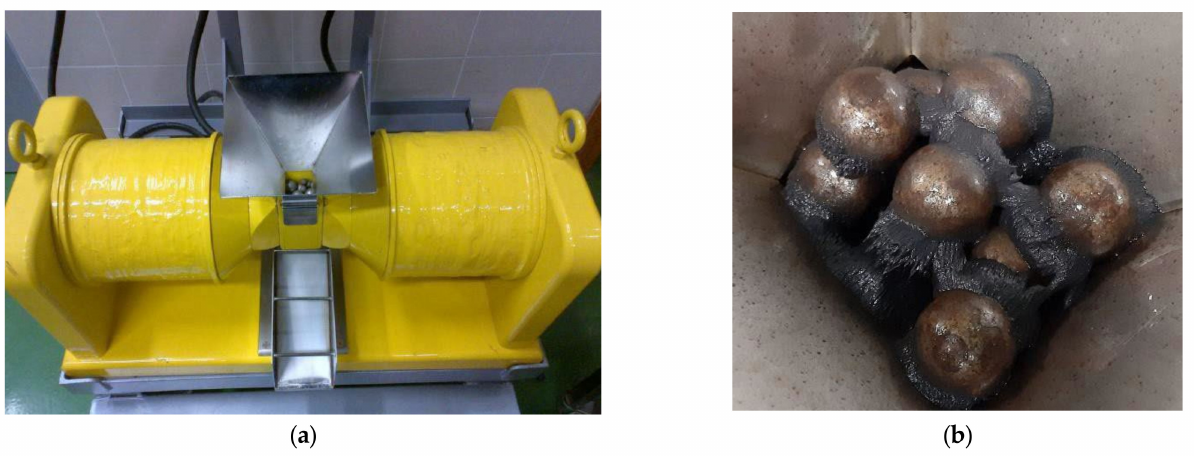
Figure 1. Magnetic separation tests at WHIMS: ( a ) separating equipment, ( b ) magnetic product retained in the